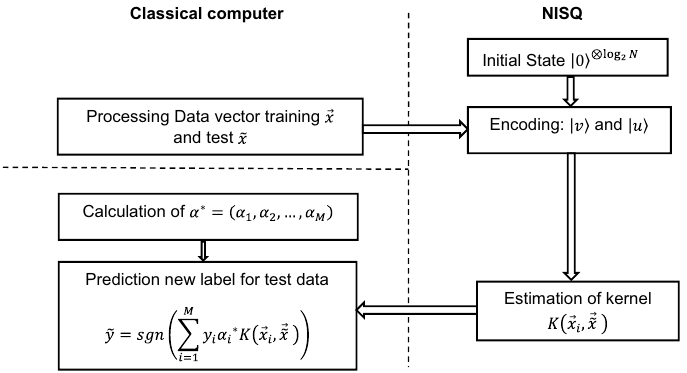
Figure 4. Schematic of the sqKSVM for data classification algorithm. First, the training data vector −→ x and test x are prepared on a classical computer. Next, the original training data and test data are encoded into quantum ˜ states followed by computing the kernel matrix of all pairs of the training-test data